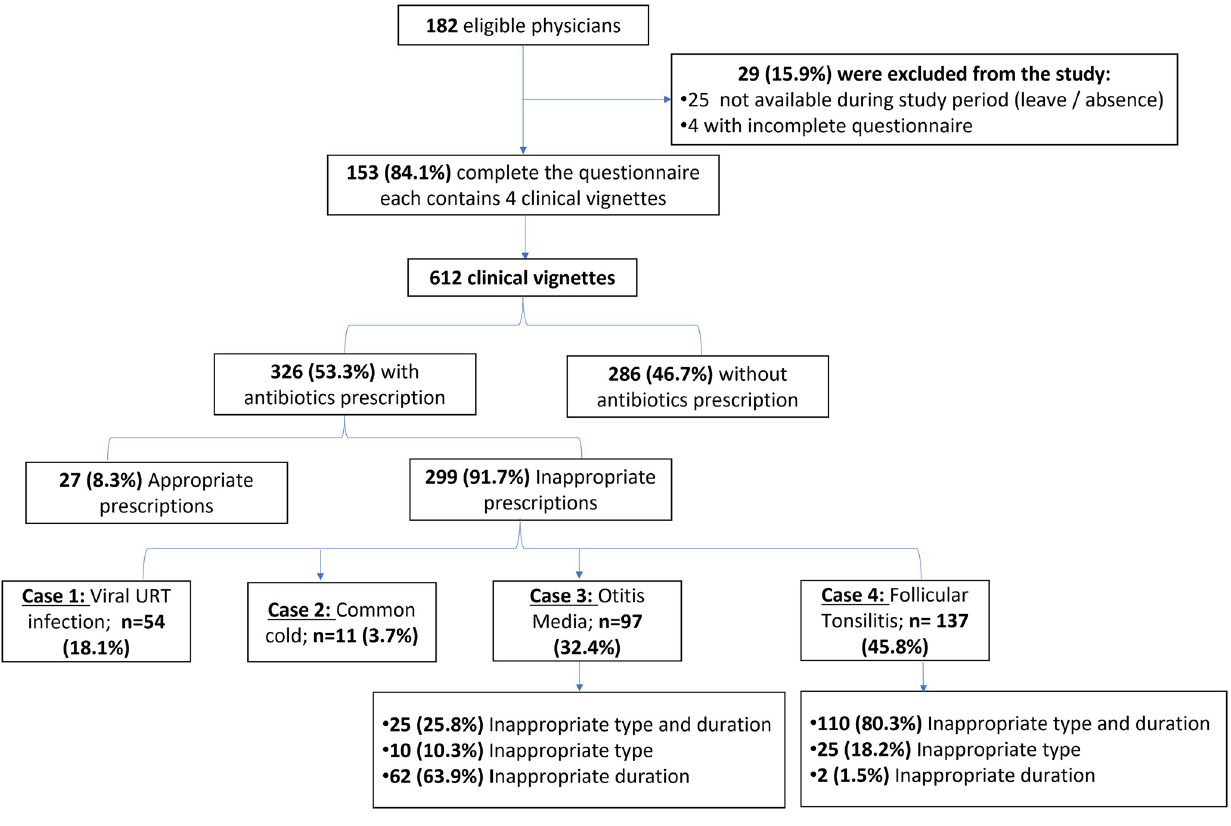
Fig 1. Flow diagram of the study illustrating responses to clinical vignettes.